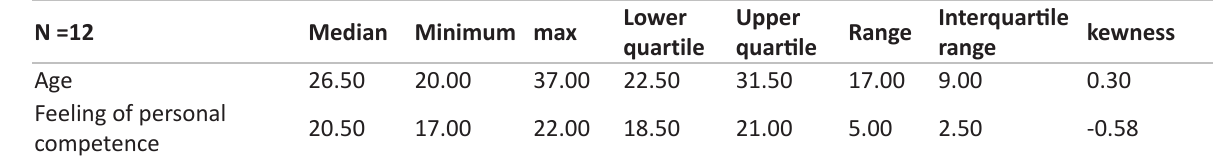
Table 5. How is a sense of personal competence of senior team in cycle speedway shaped? N